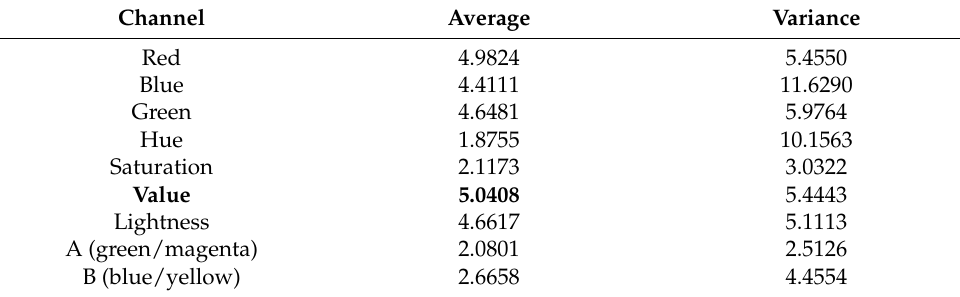
Table 1. Average and variance of CNR values of each channel.